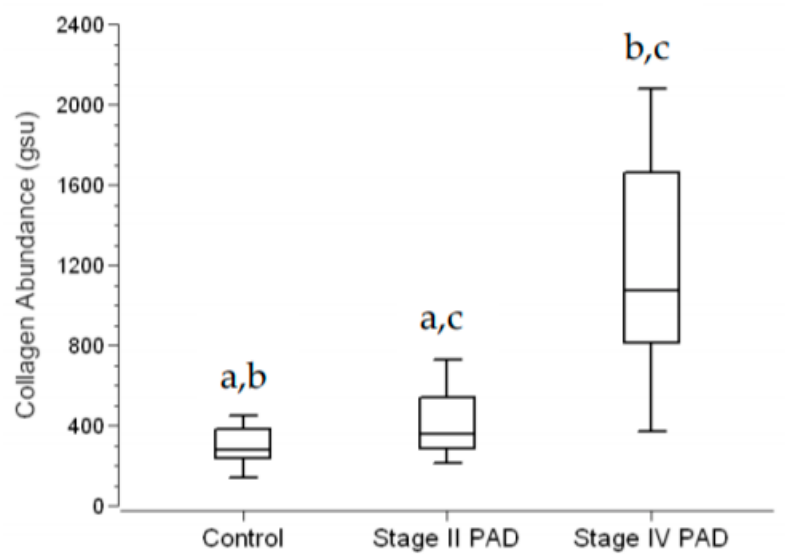
Figure 4. Inter-myofiber Collagen Abundance in Calf Muscle of Control Subjects and Patients with Peripheral Artery Disease (PAD). Calf muscle biopsies were taken from control subjects ( N = 14) and patients with Stage II ( N = 15) and Stage IV PAD ( N = 15), embedded in paraffin, sectioned at four